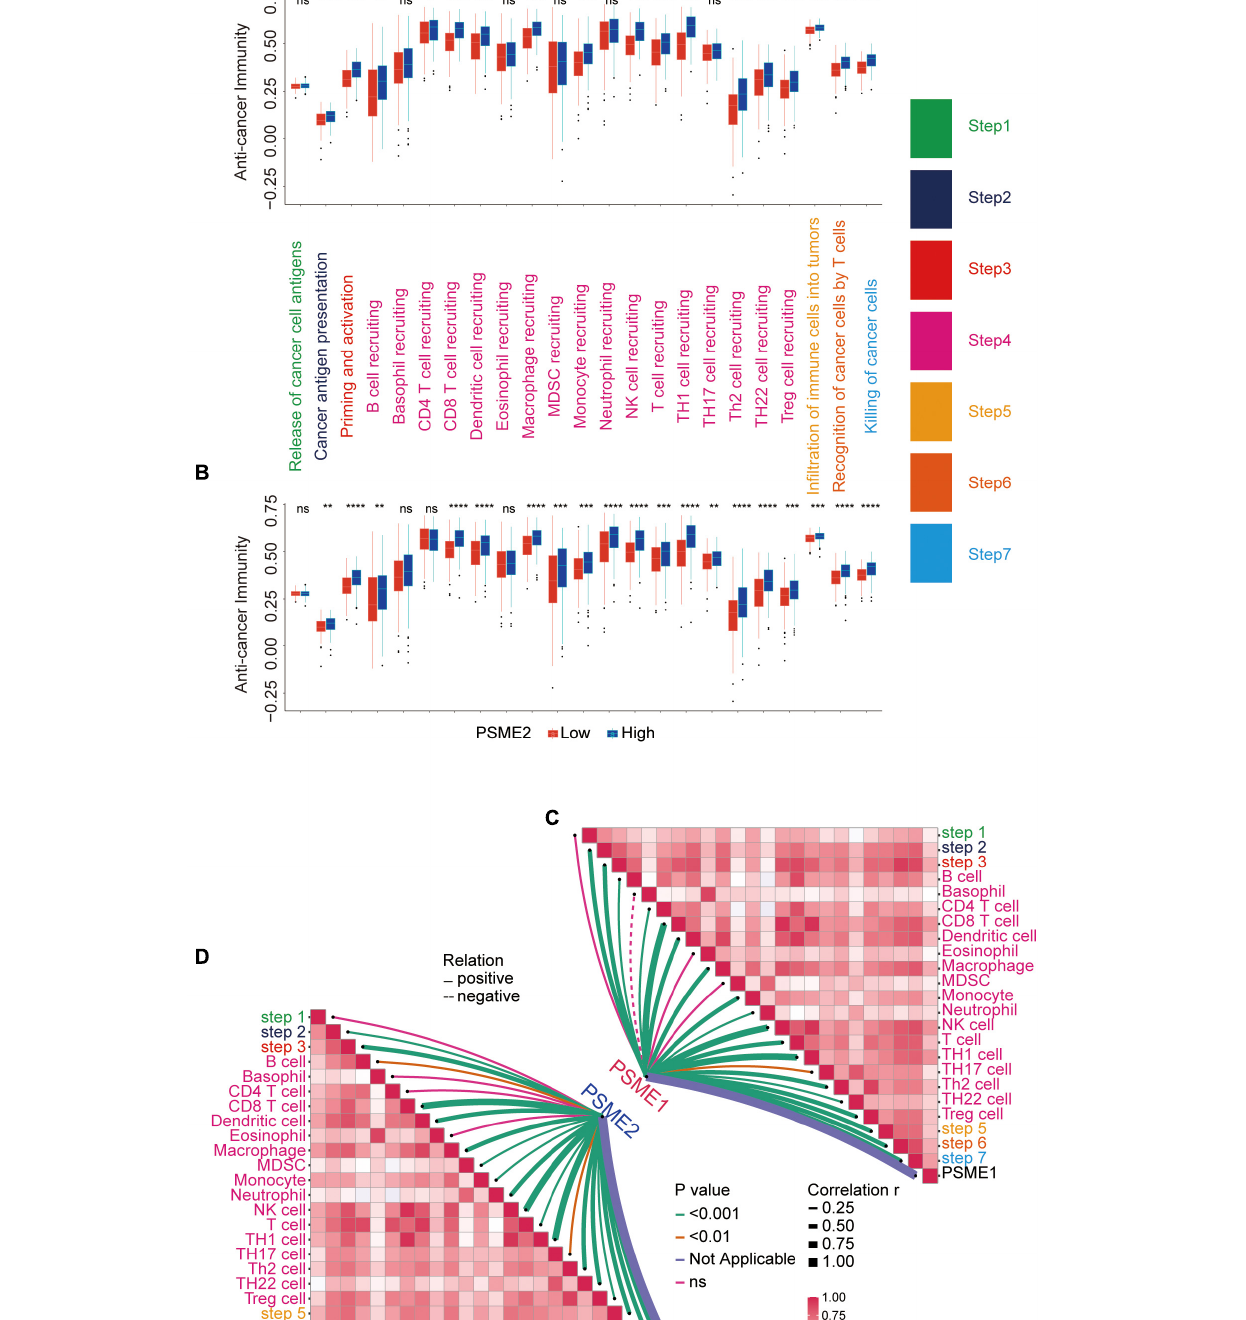
Frontiers in Cell and Developmental Biology |